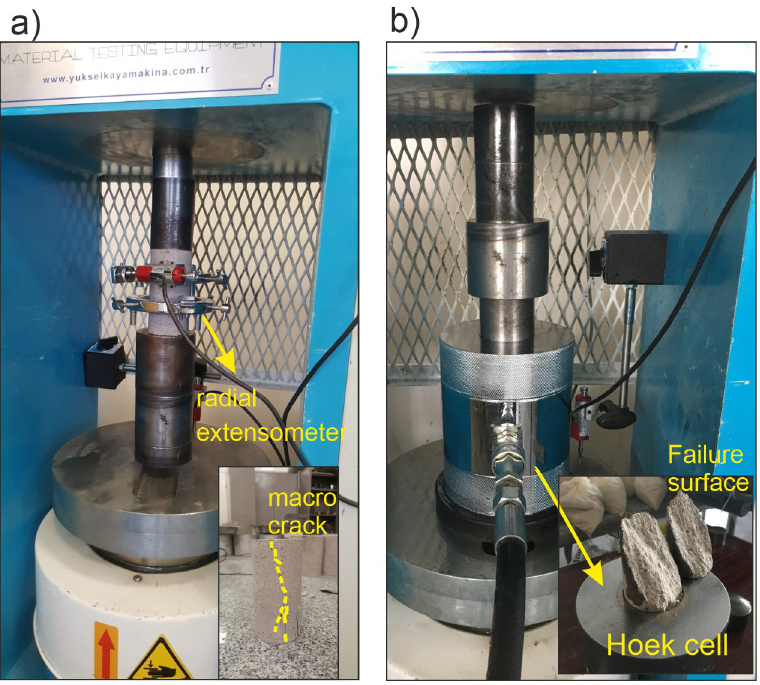
Fig 1. Implementation of laboratory tests under compressive loading conditions. (a) Uniaxial compressive strength test (b) Triaxial compressive strength test.